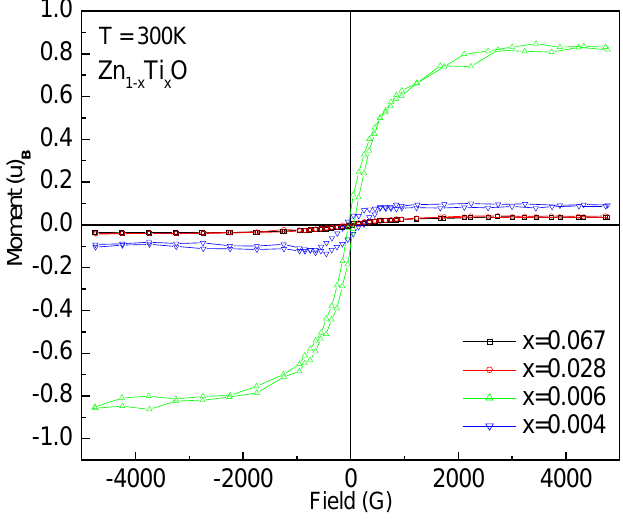
Figure 6. M-H loops measured at room temperature for Ti-doped ZnO